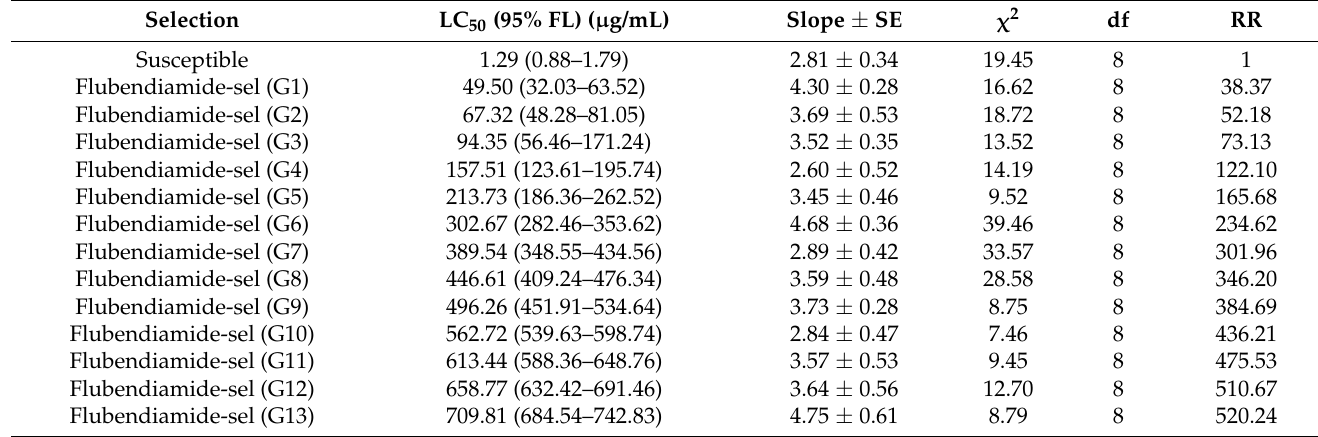
Table 3. The resistance levels of Tuta absoluta to flubendiamide during the selection